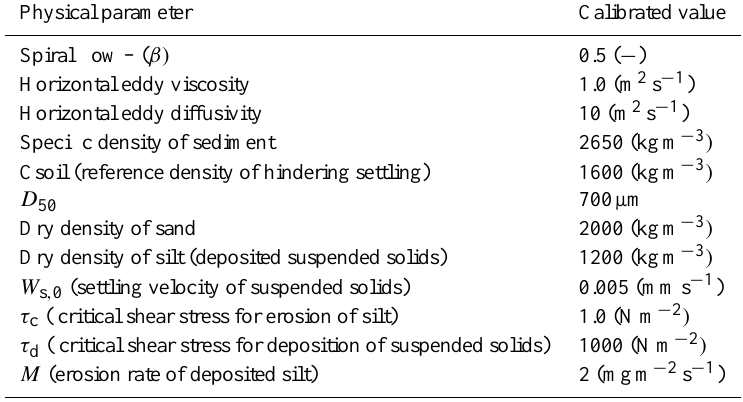
Table 2. The values of physical parameters derived from the calibration process.